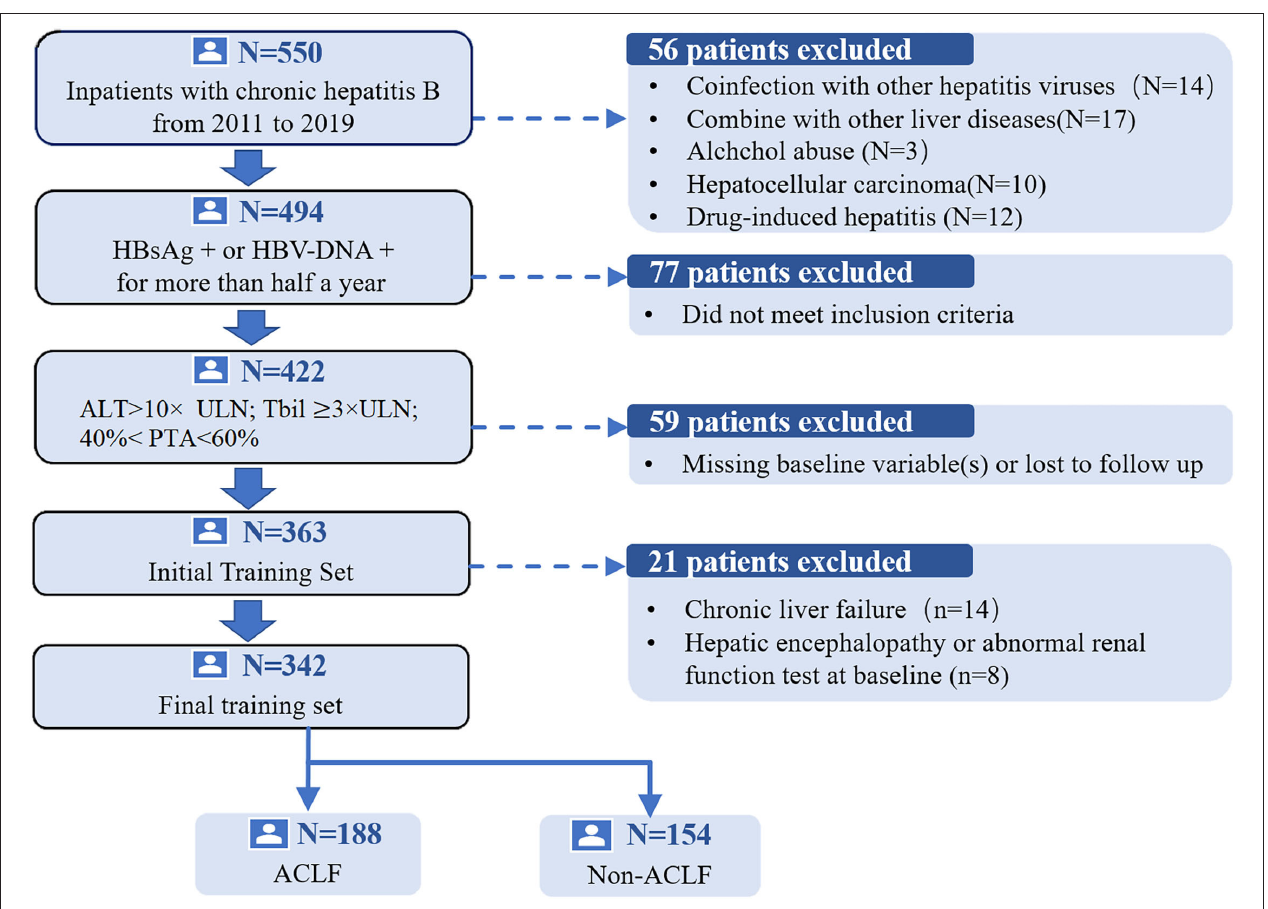
FIGURE 1 | The flow chart of the study group selection process.HBsAg, hepatitis B surface antigen; ALT, alanine aminotransferase; ACLF, acute-on-chronic liver failure; PTA, prothrombin activity; TBil, total bilirubin; ULN, upper limit of